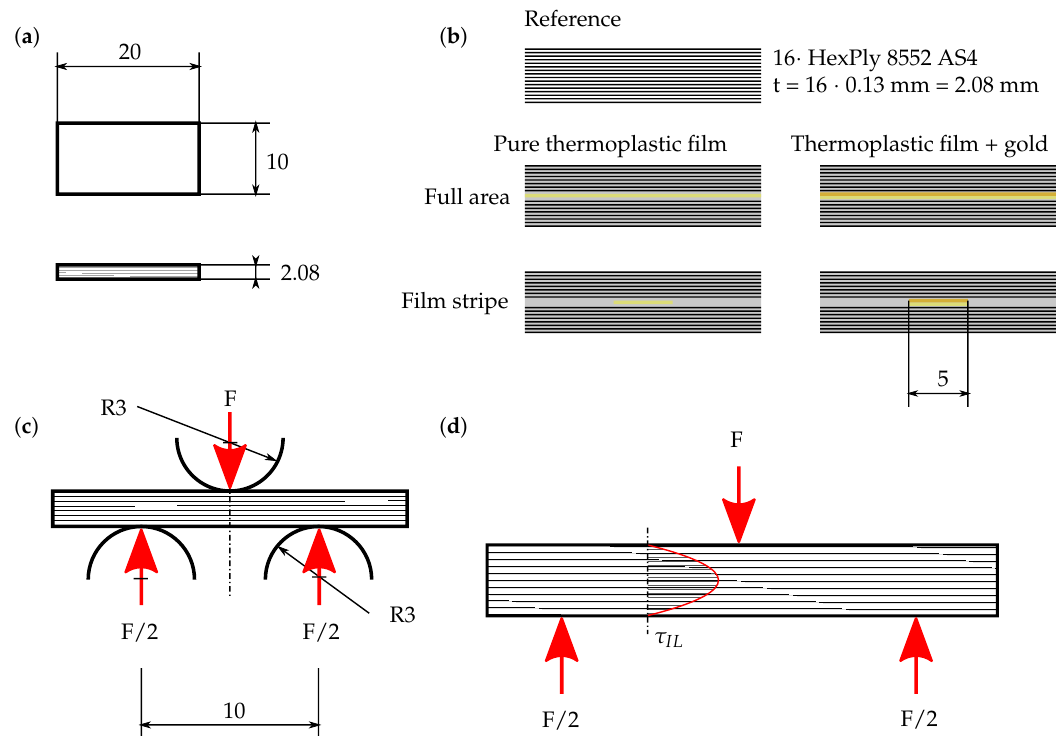
Figure 3. ILS testing device and specimen layup: ( a ) Specimen geometry. ( b ) Prepreg layers and integrated thermoplastic films with or without gold coating. ( c ) Geometry of the testing device. ( d ) Shear stress due to specimen